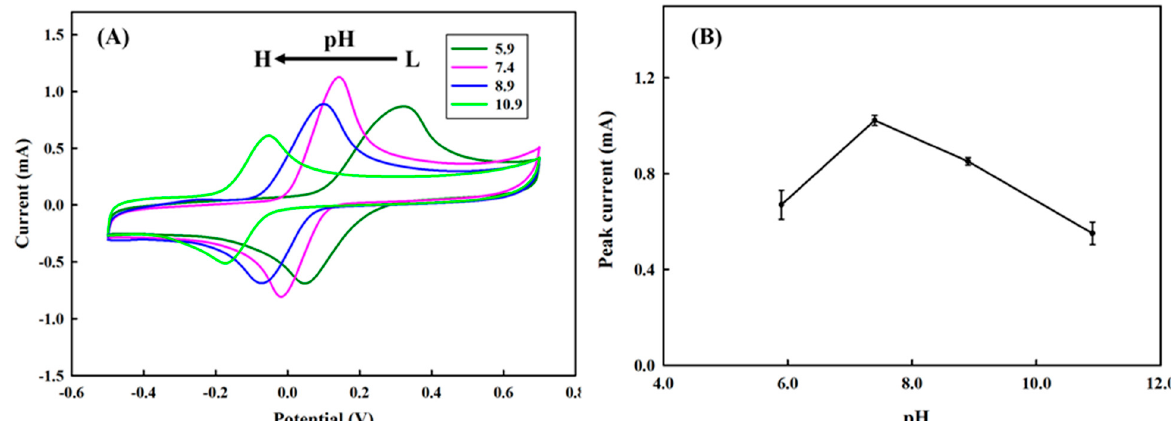
Figure 5. ( A ) The effect of pH on the cyclic voltammetry profiles for the detection of 6 mM of hydroquinone in 100 mM of PBS buffer, where pH 5.9 (green), pH 7.4 (pink), pH 8.9 (navy), and pH 10.9 (limo). The potential was swept from − 0.5–0.7 V with the rate of 100 mV s − 1 . ( B ) The effect of pH on the anodic peak current.